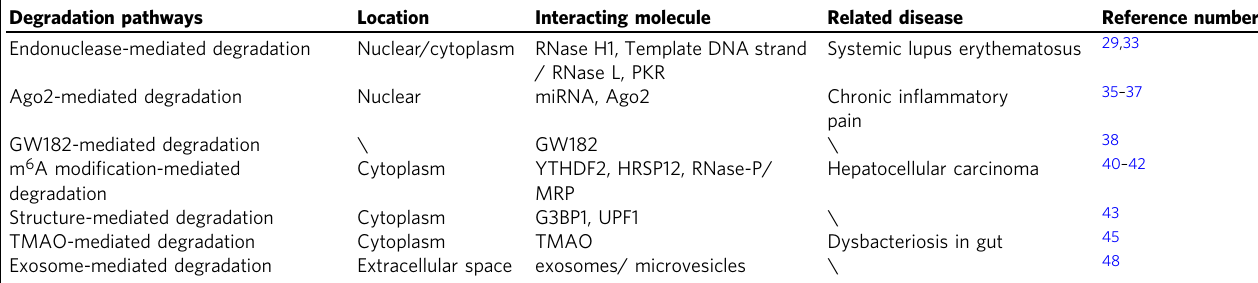
Table 2 Pathways of circRNAs